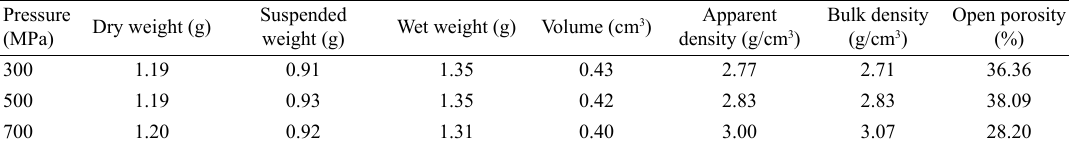
Table 1. Apparent density, Bulk density and Open porosity for three samples pressed under 3 different pressures.